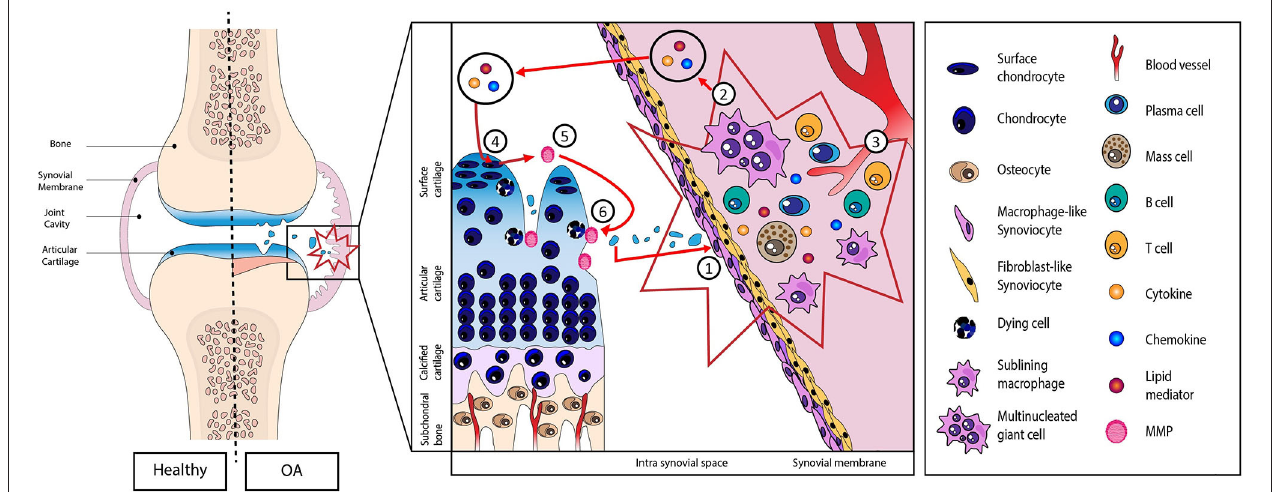
FIGURE 1 | Schematic representation of the role of damage-associated molecular patterns (DAMPs) in the initiation and perpetuation of the low-grade systemic inflammation. (1) DAMPs released from extracellular matrix to the joint cavity during cartilage degradation. (2) Proliferation and hyperplasia of the lining cells along with inflammatory cell infiltration and (3) neoangiogenesis. (4) Production of inflammatory mediators (cytokines, chemokines, lipid mediators, and DAMPs themselves) into the synovial fluid. (5) These mediators then activate chondrocytes that in turn produce metalloproteinase resulting in a vicious cycle (6) between cartilage and synovial